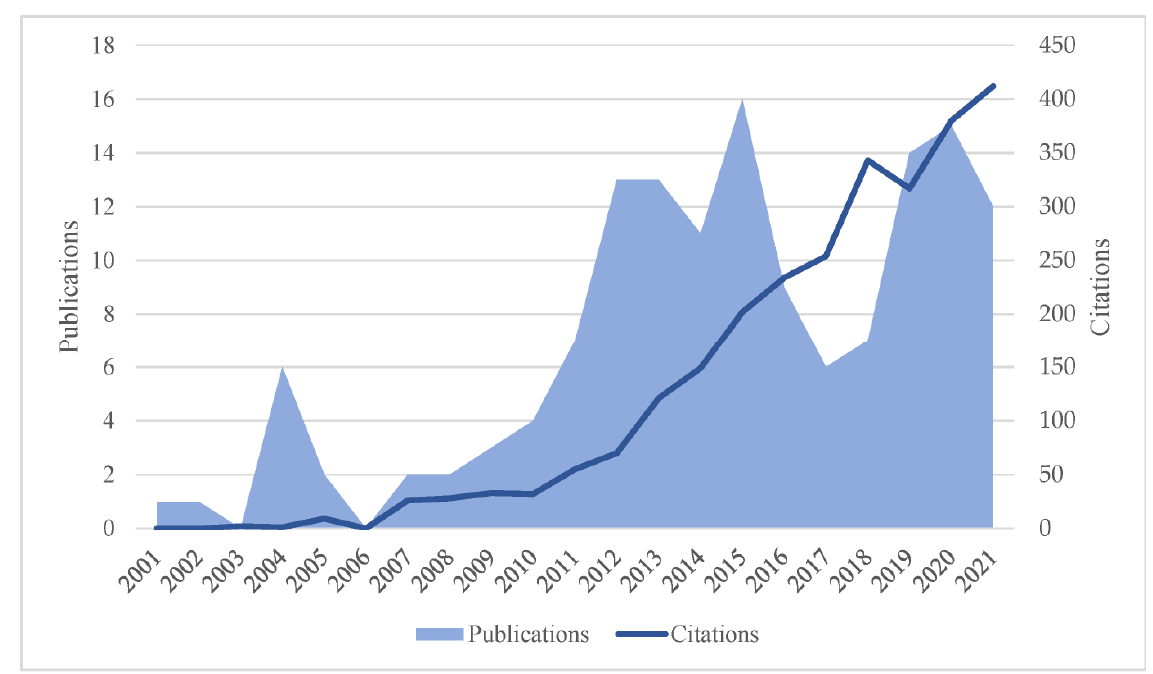
Figure 5. Time evolution of publications and their citations. Table 6. Most cited